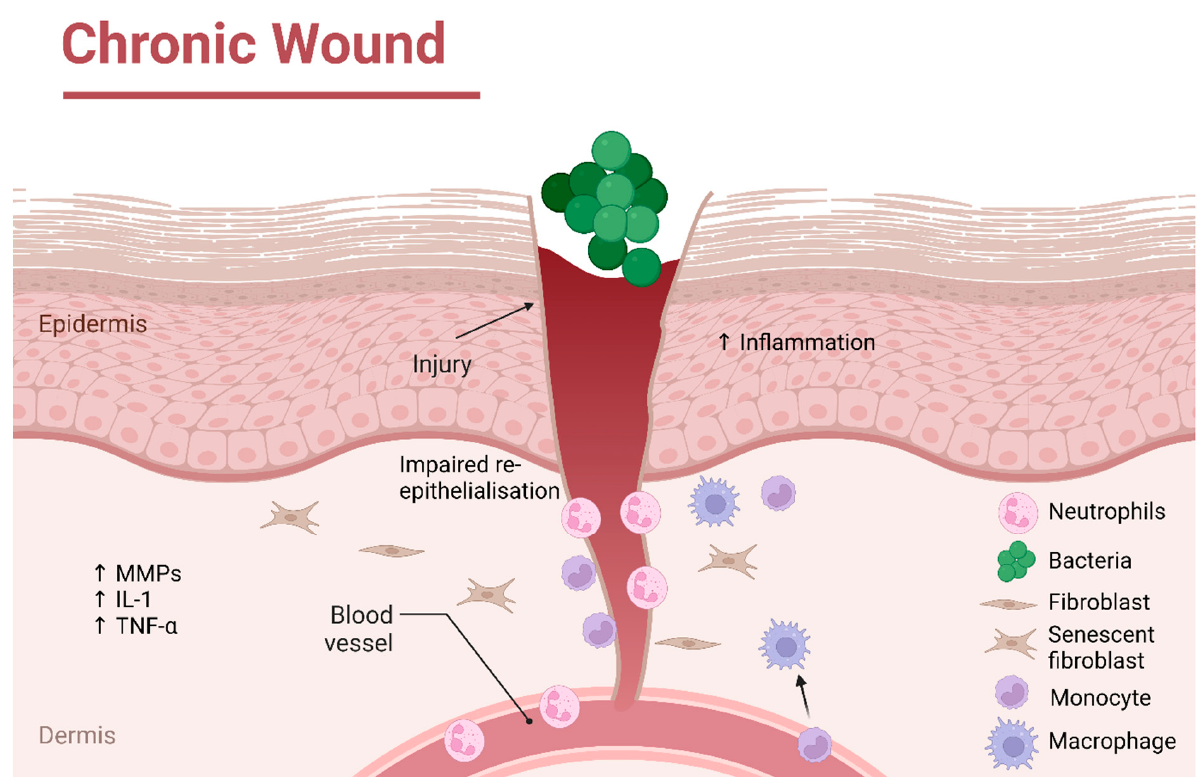
Figure 1. Schematic overview of the chronic wound environment, depicting key differences in the wound healing response compared to acute wounds. Created with